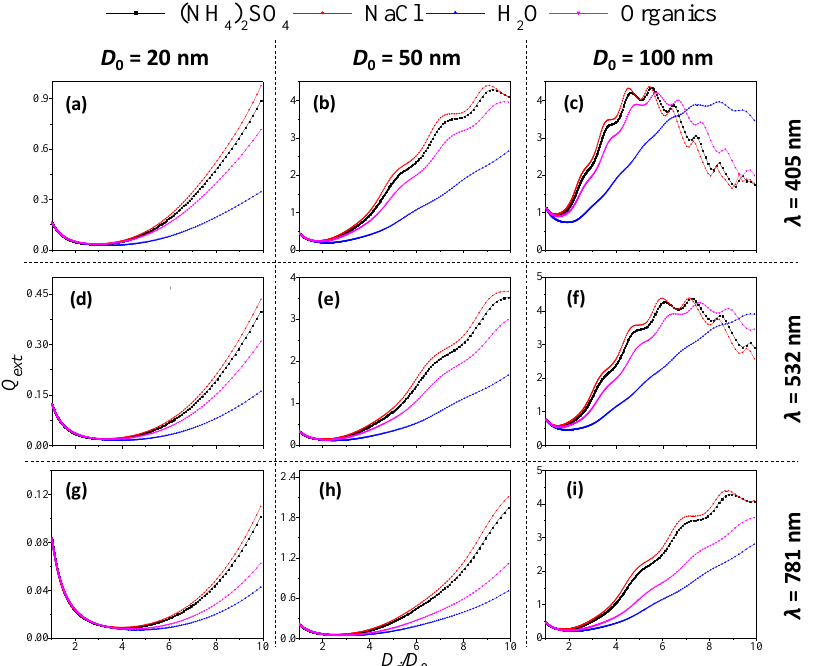
Figure 5. Variation in extinction efficiency ( Q ext ) with coating thickness ( D i /D 0 ) under various soot-particle coated materials ( λ = 405, 532 and 781 nm; D 0 = 20, 50 and 100 nm). ( a )–( c ): ( λ = 405 nm; soot particle core diameter D 0 = 20, 50 and 100 nm); ( d )–( f ): ( λ = 532 nm; soot particle core diameter D 0 = 20, 50 and 100 nm); ( g )–( i ): ( λ = 781 nm; soot particle core diameter D 0 = 20, 50 and 100 nm);